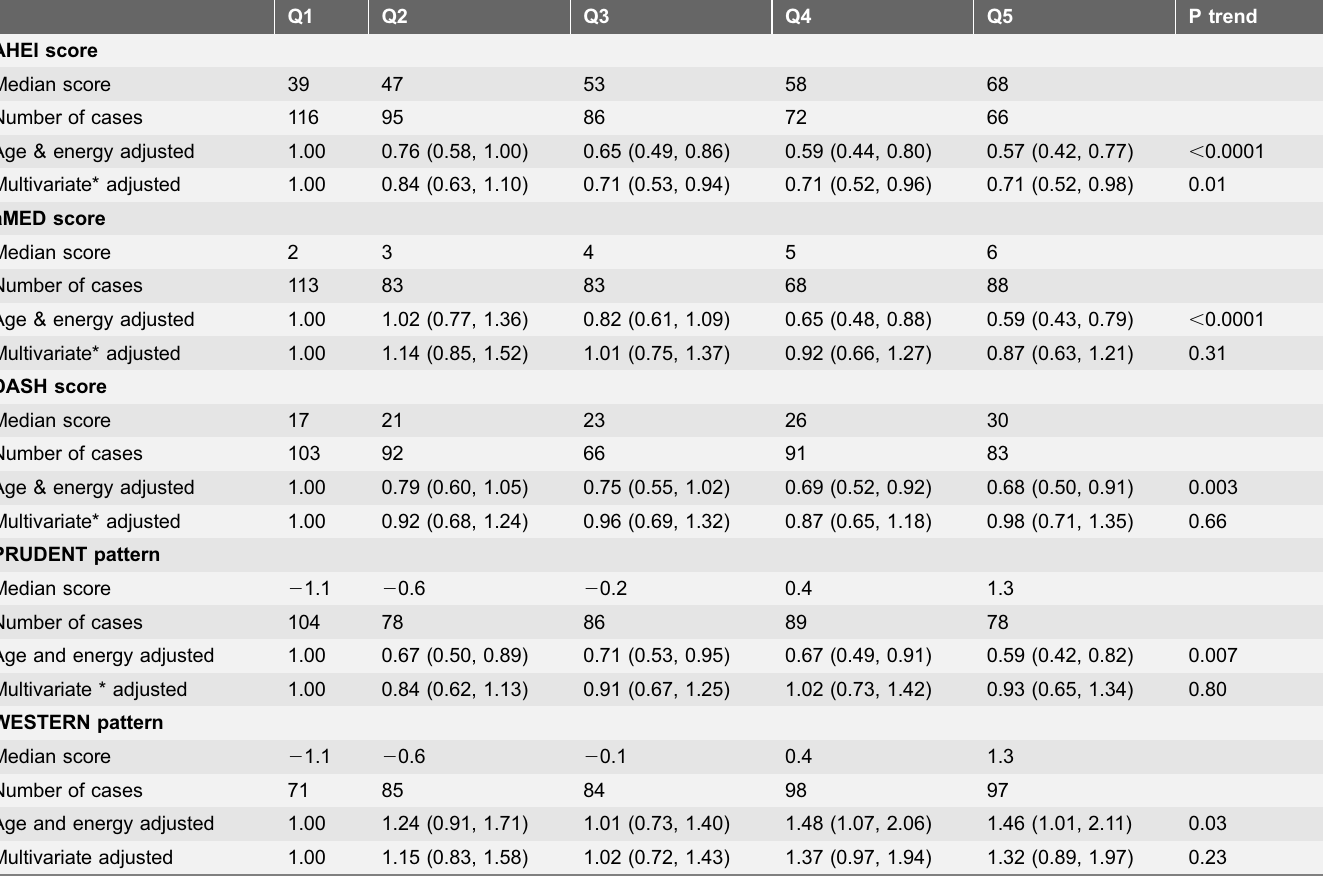
Table 2. Association between quintiles of post-diagnosis diet score (Hazard ratio and 95% CI) and overall